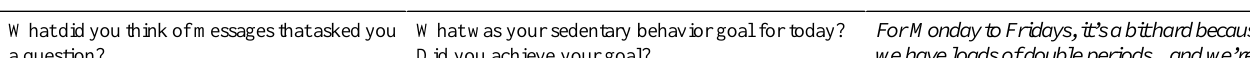
Examples of adolescent responses a Example text messageQuestion to